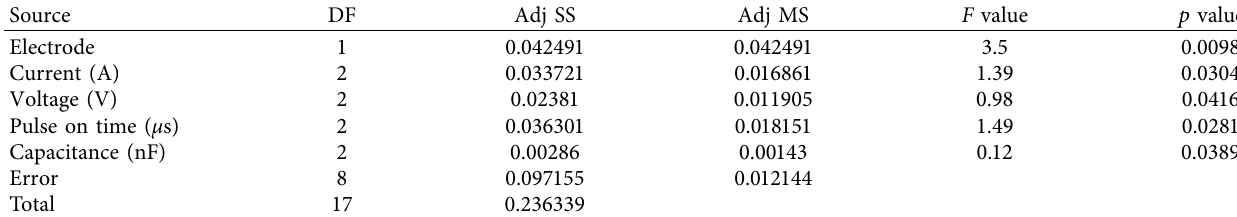
Table 7: ANOVA of EWR.